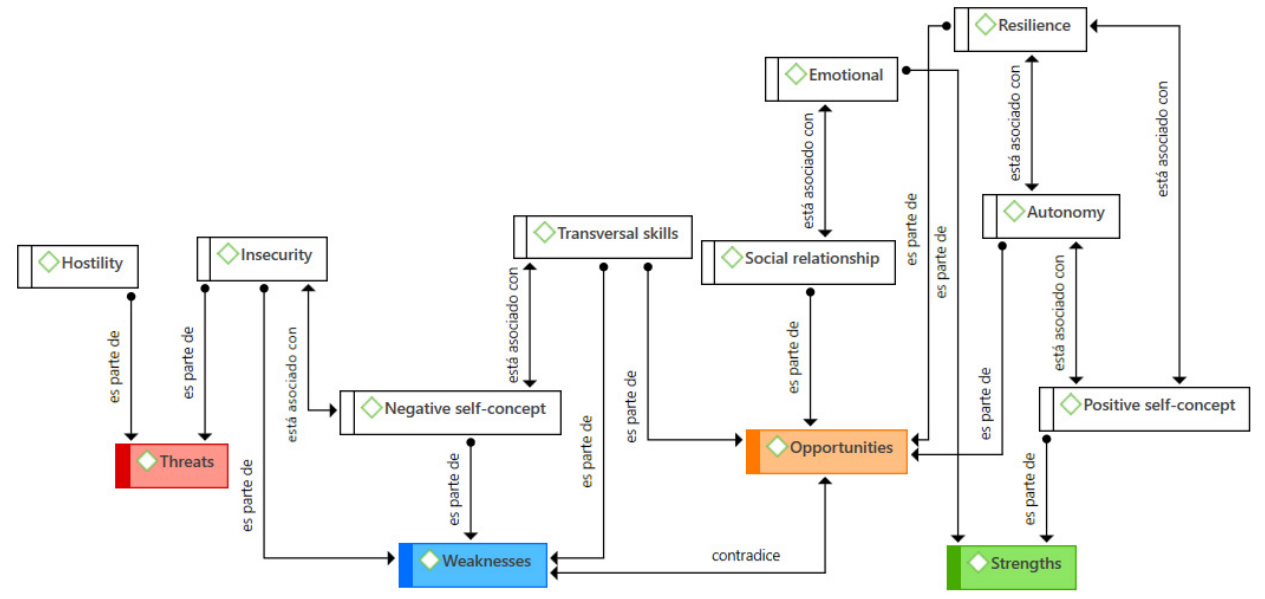
Figure 5. Semantic network with the main relationships between codes.